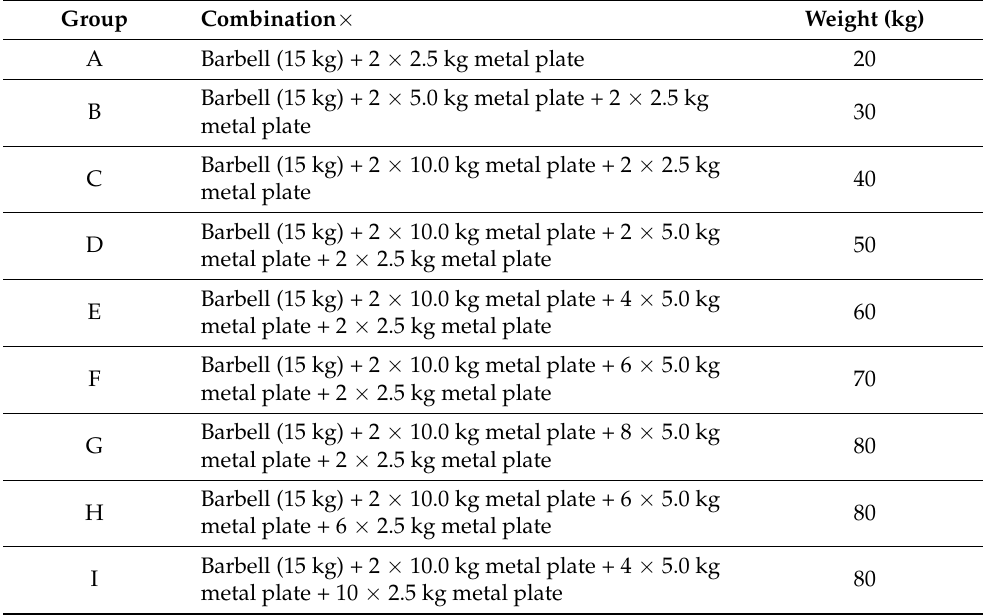
Table 2. Combinations of various weight plates.